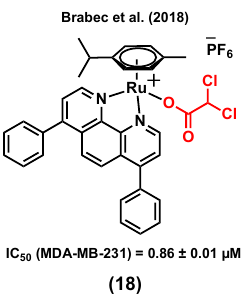
Figure 6. A ruthenium complex bearing dichloroacetato